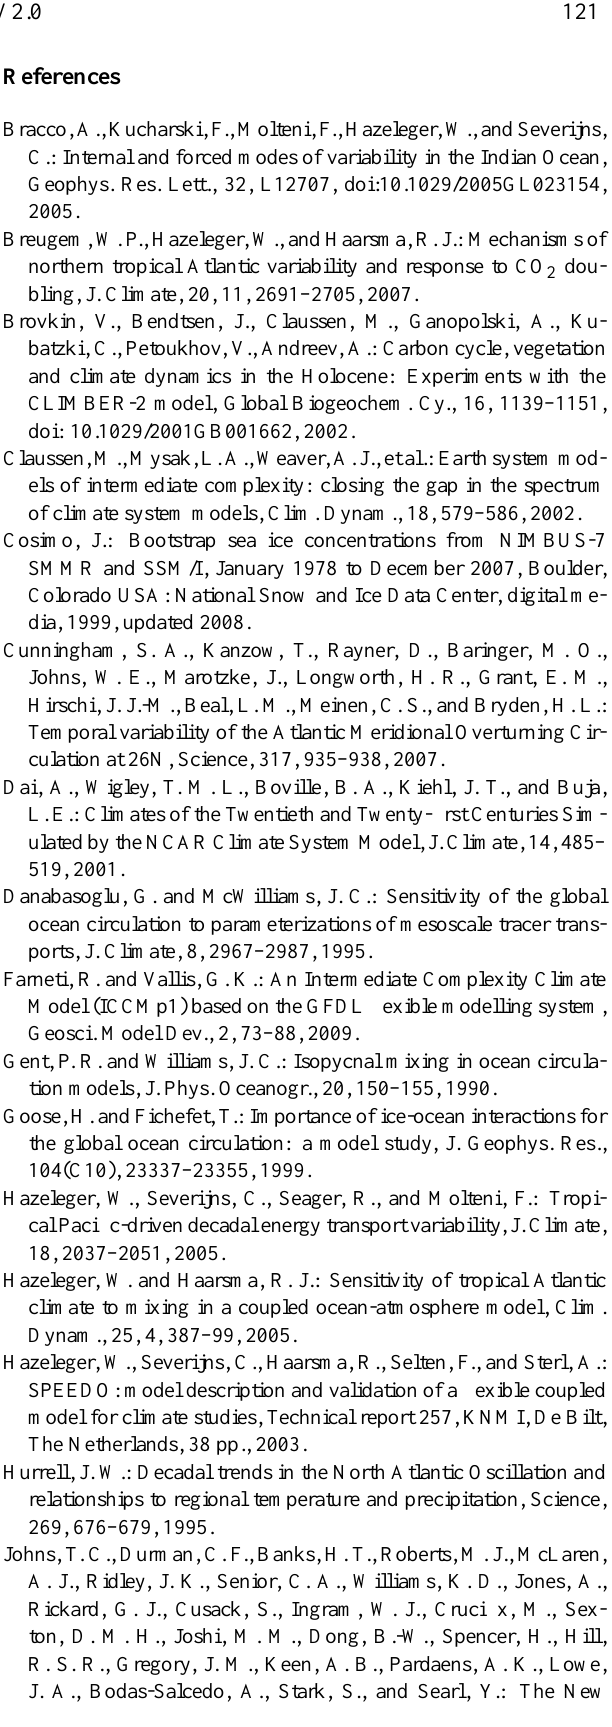
Fig. 24. The annual global mean two meter air temperature in K (red) and prescribed CO 2 concentration in ppm (blue) in the sce- nario run.